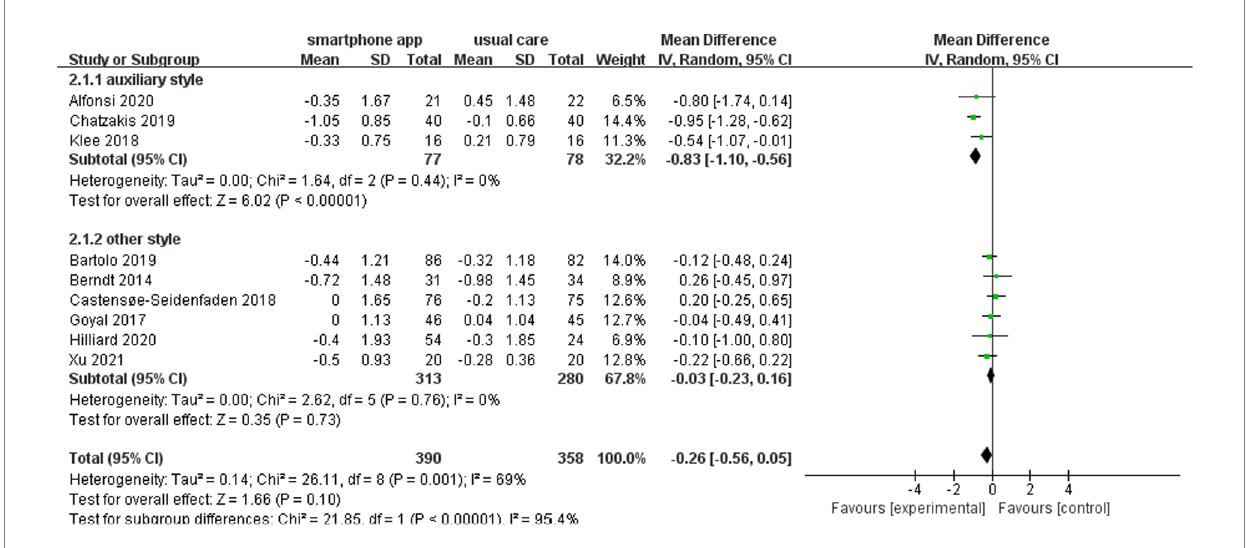
FIGURE 4 Forest plot of smartphone app interventions with different styles and changes in HbA1c.